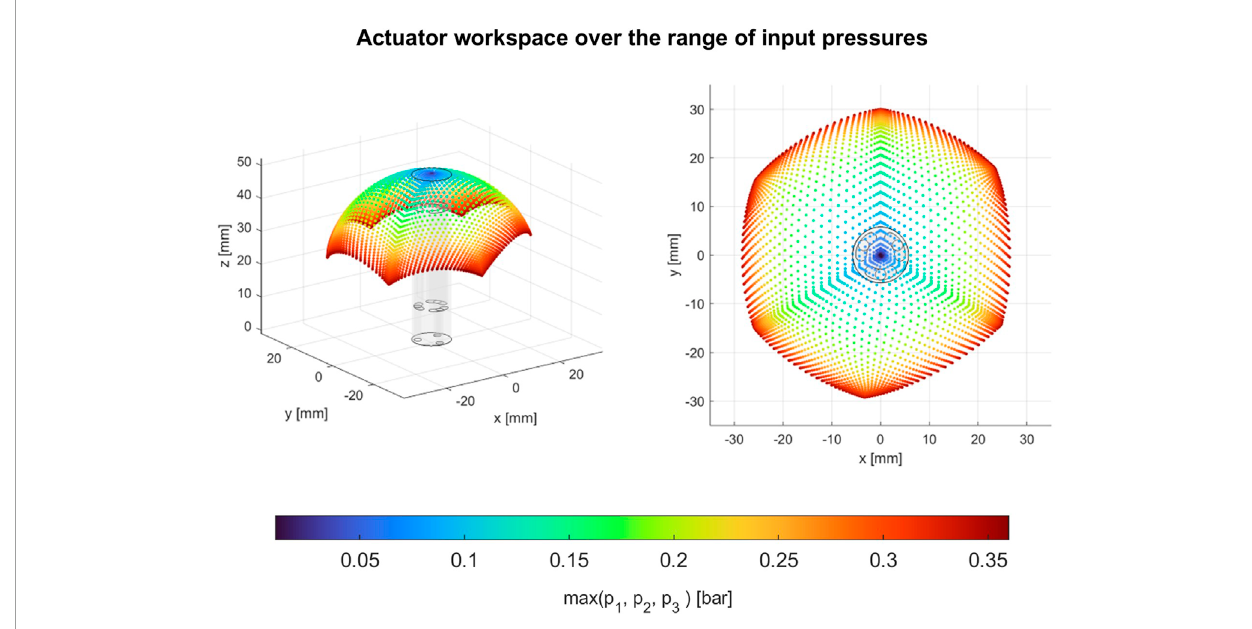
FIGURE 9 Robot’s 2D workspace in 3D space, based on the characterization data combined with module kinematics. High input pressure regions are shown in red, while low input pressure regions are shown in